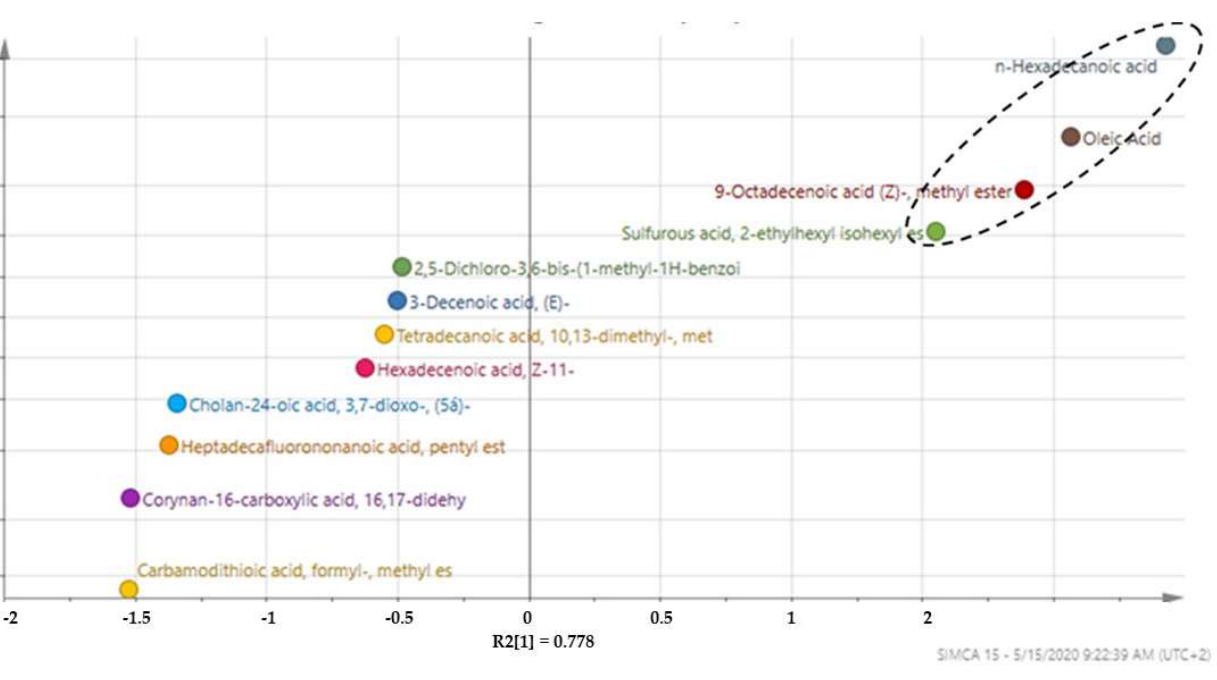
Figure 3. Probability plot of volatiles compounds in the dichloromethane extract of MOS oils indicating the three marker compounds insert the perforated oval.